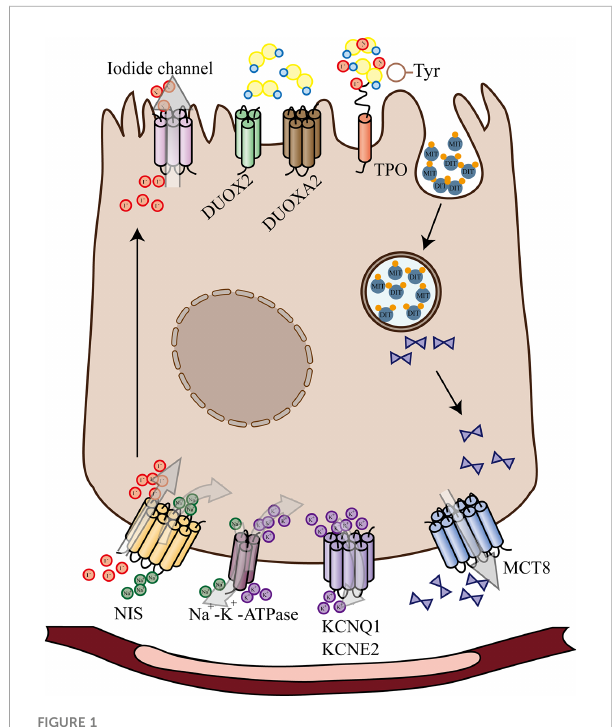
FIGURE 1 Schematic Diagram of Thyroid Hormone Biosynthesis and